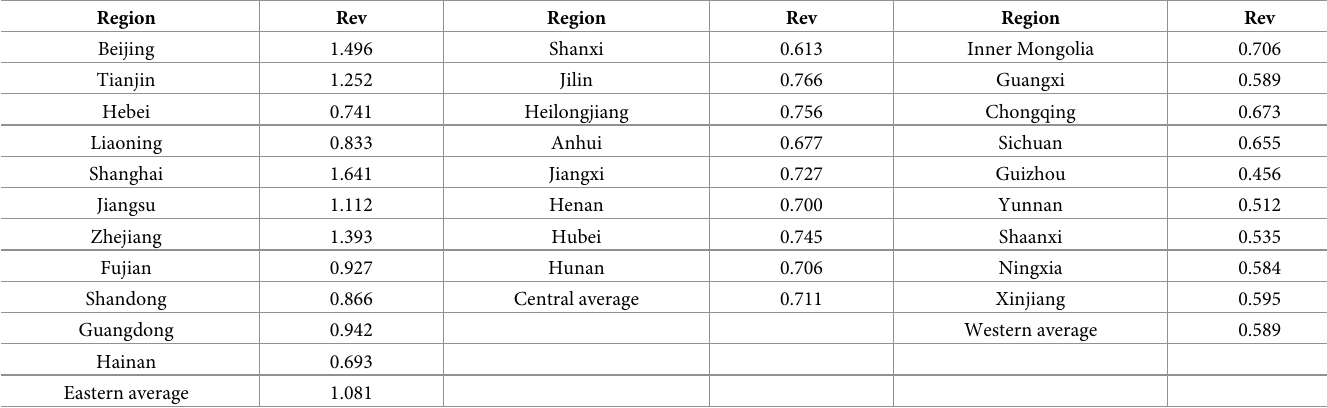
Table 4. Average value of farmers’ income of 28